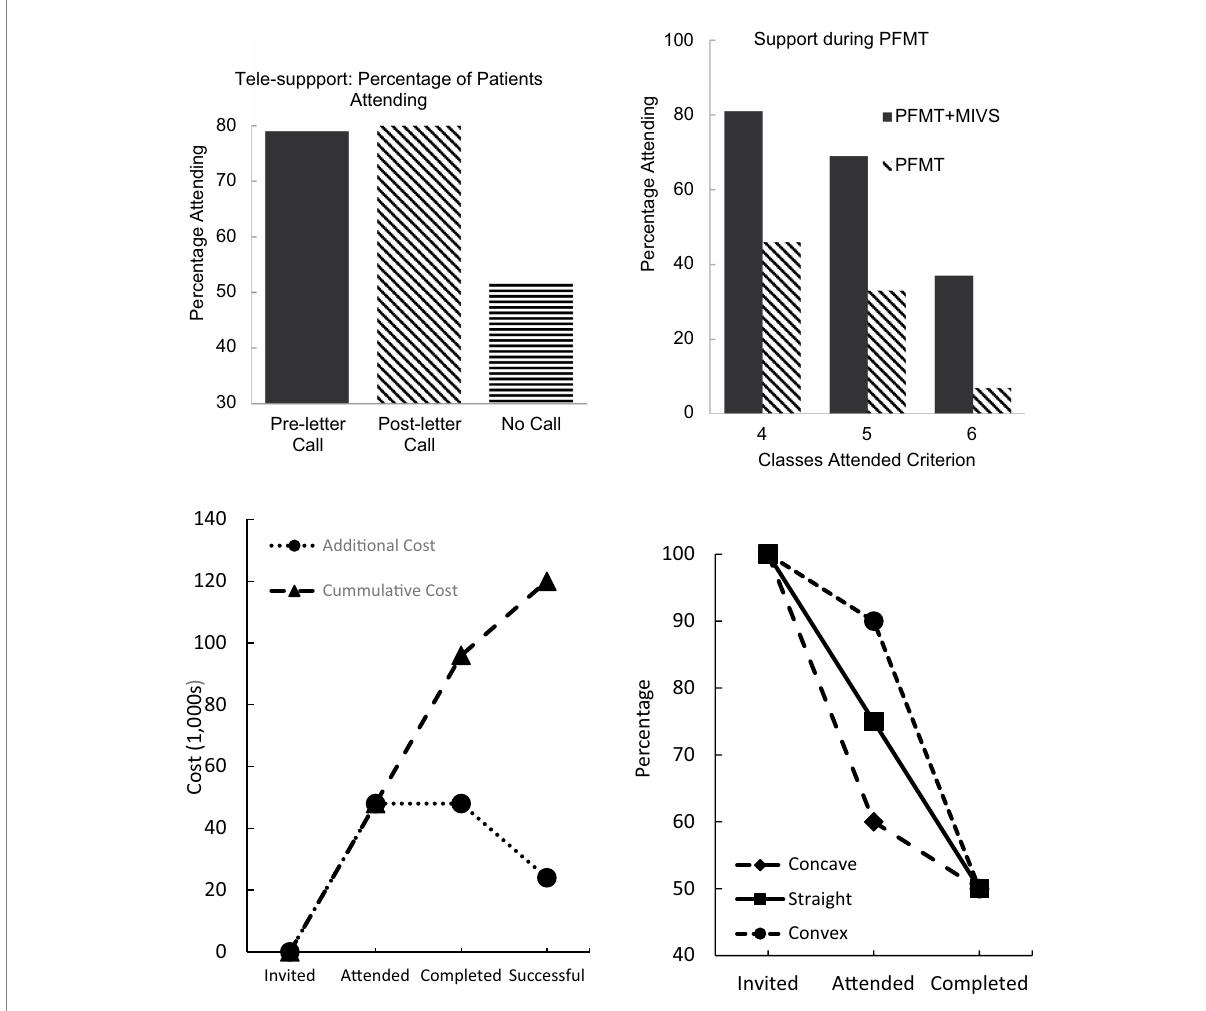
FIGURE 2 Top left = attendance at initial pelvic-floor muscle training (PFMT) session following brief tele-support (Osborne et al., 2017a). Top right = attendance at PFMT sessions with and without psychological support (Osborne et al., 2016). Bottom left = economic savings from reduced attrition. Bottom right = three type of attrition